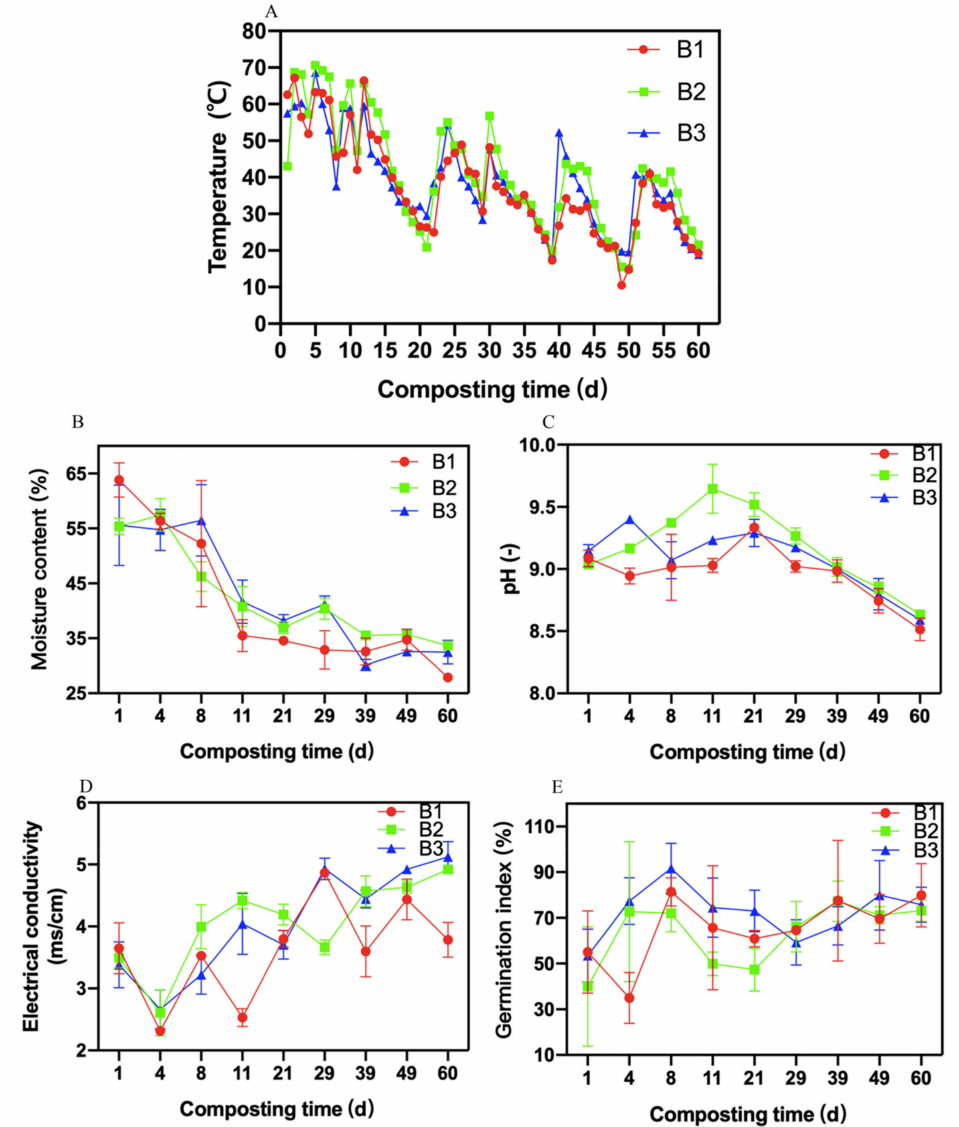
Figure 1. Changes in physicochemical indicators of compost under different treatments. ( A ): Temper- ature; ( B ): Moisture content; ( C ): pH; ( D ): Electrical conductivity (EC); ( E ): Germination index (GI). Error bars represent standard deviations of measurements (n =